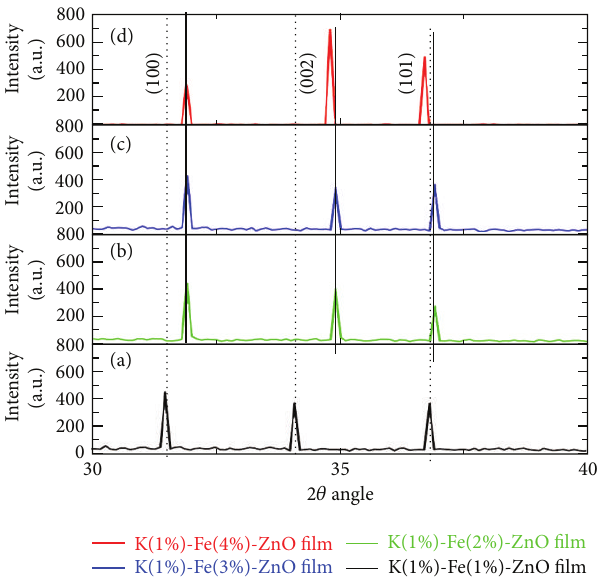
Figure 1: XRD pattern of (K (1%), Fe) codoped ZnO for Fe concentrations: (a) 1%, (b) 2%, (c) 3%, and (d) 4%.